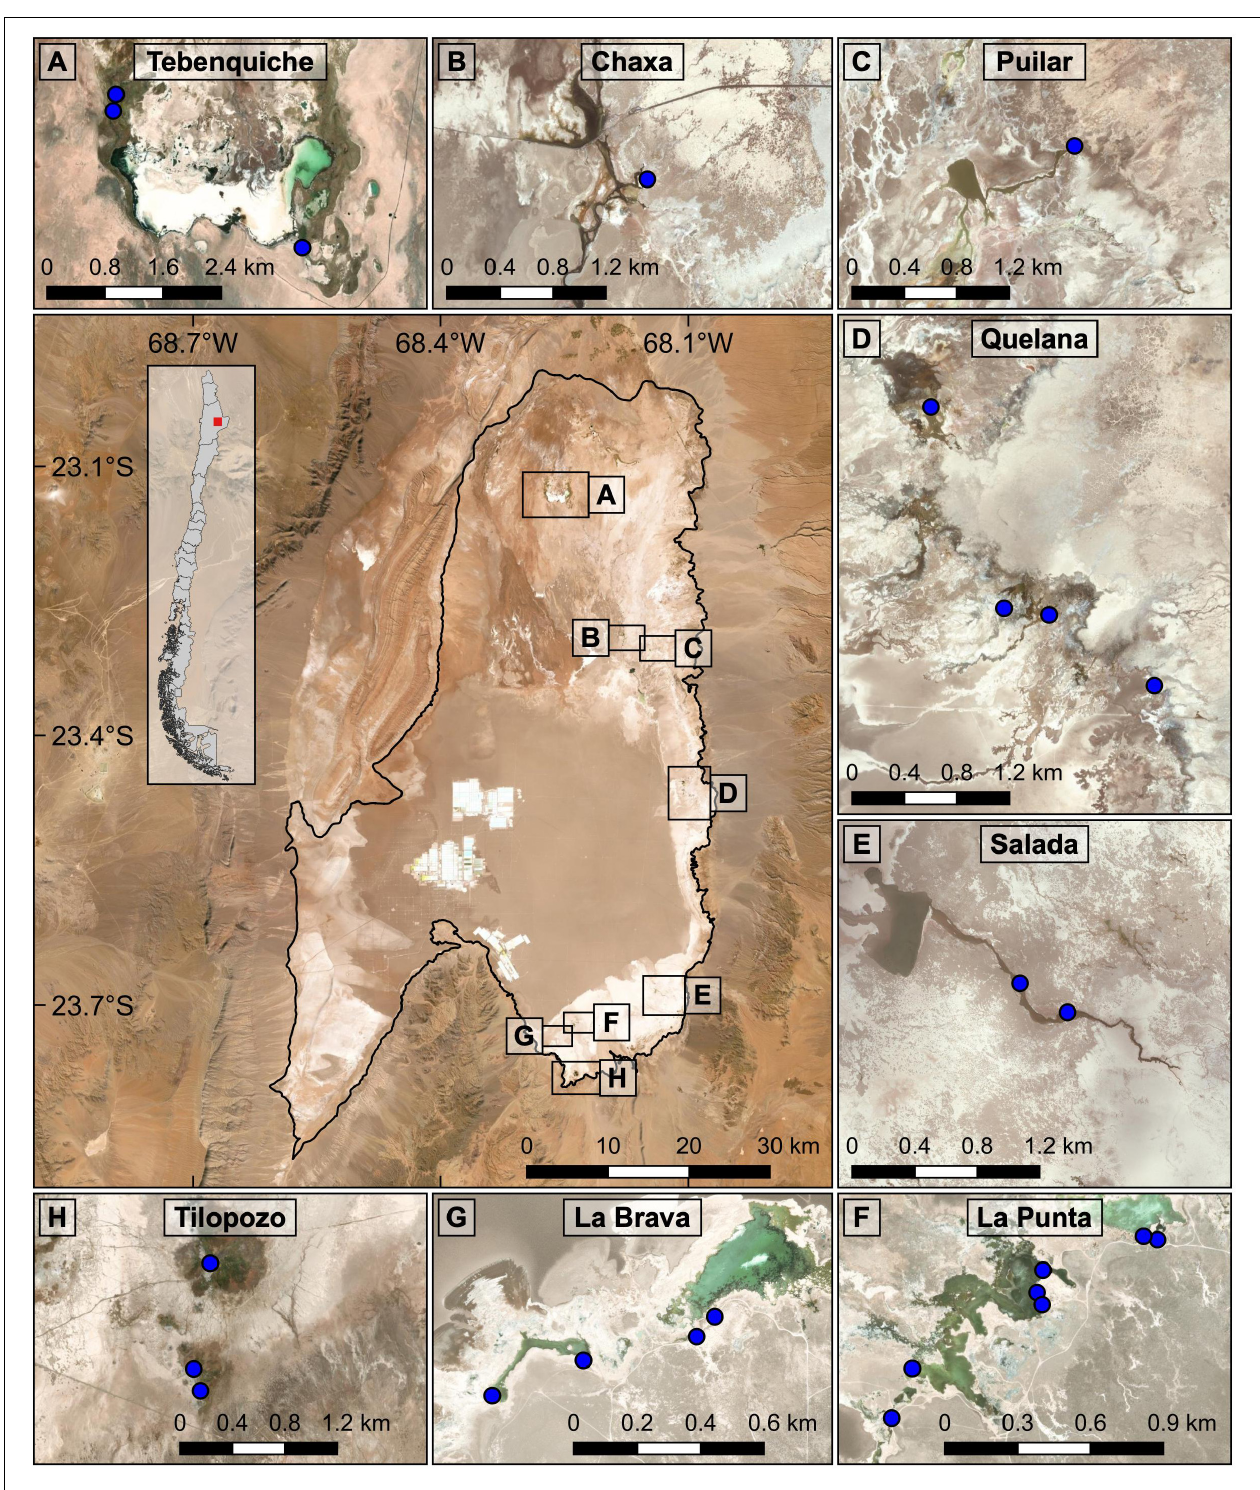
FIGURE 1 | Map showing the Atacama Saltpan. The boundary of the saltpan is depicted in the central figure. The eight systems analyzed and the sampling points considered for each system are indicated (A–H) . Maps created in QGIS Geographic Information System v3.4.9 with ESRI world imagery (ESRI, DigitalGlobe, GeoEye, Earthstar Geographics, CNES/Airbus DS, USDA, USGS, AeroGRID, IGN, and the GIS User Community).